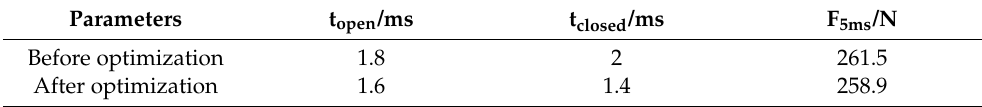
Table 7. Target comparison before and after optimization.